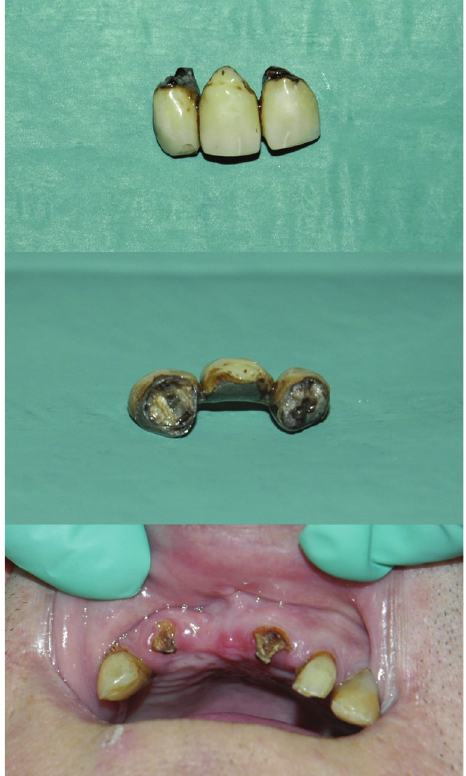
Figure 1: Detached dental bridge and teeth decay under the pros-